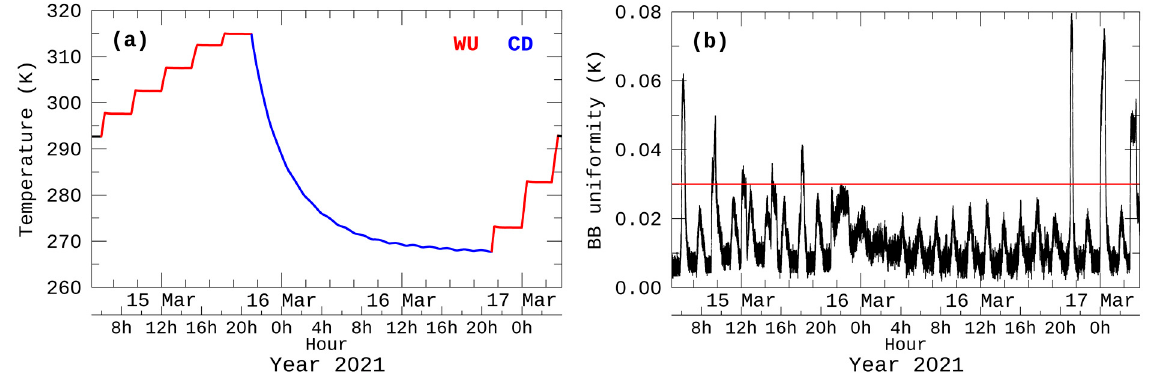
Figure 2. S-NPP VIIRS BB ( a ) temperature and ( b ) uniformity with requirement (red line) throughout an entire WUCD operation from 15 March to 17 March 2021.